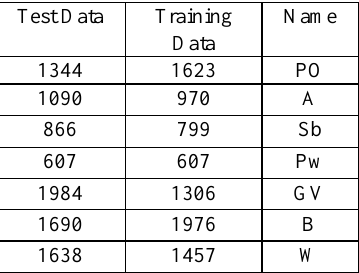
Table 1 training data and test data